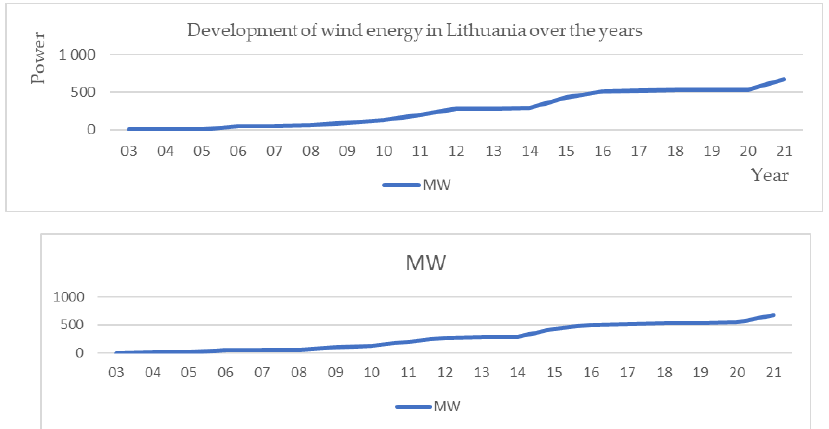
Figure 2. Development of wind energy in